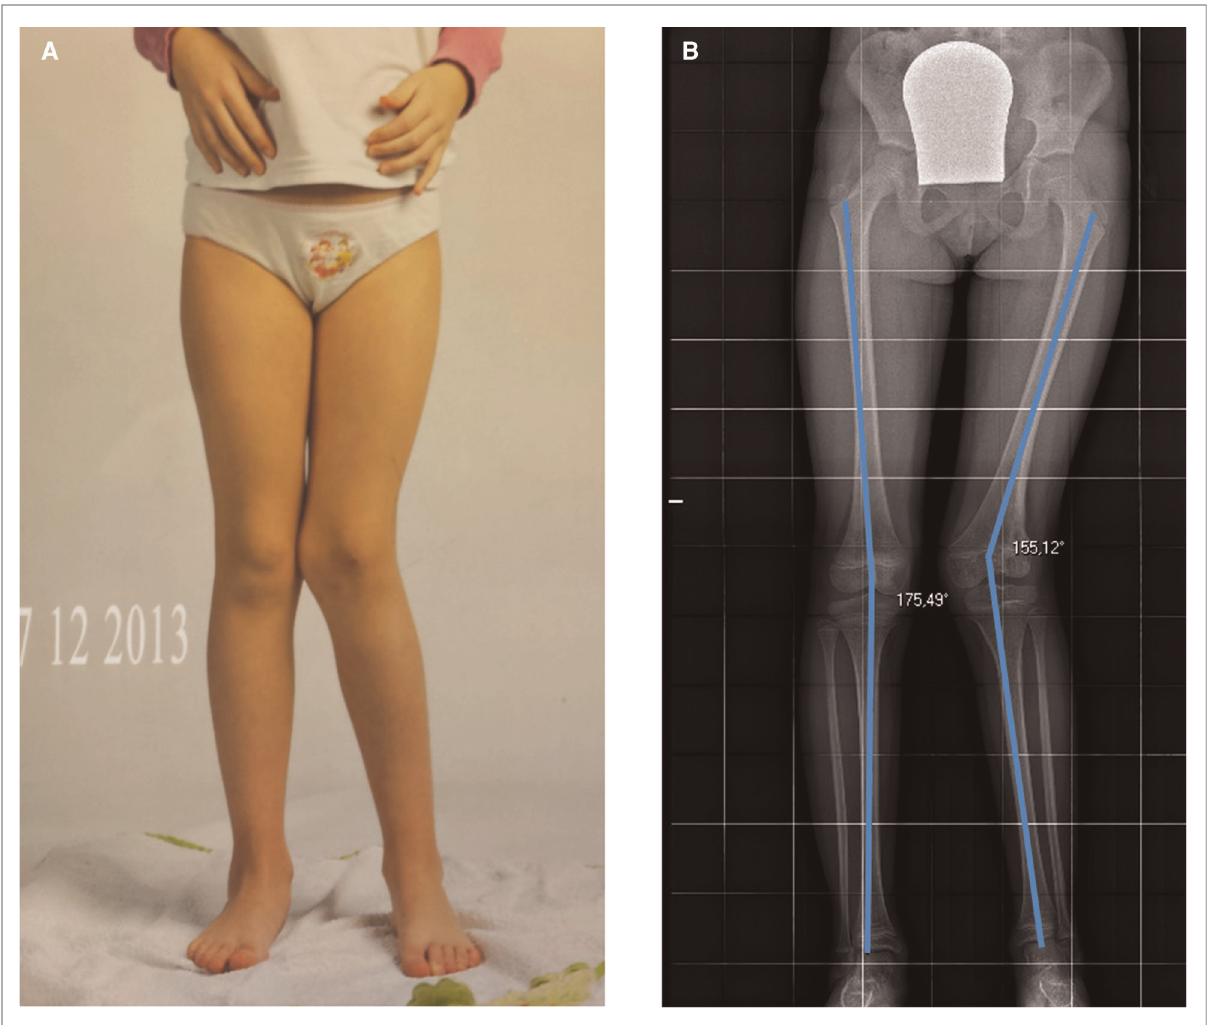
FIGURE 6 Twenty-month post-trauma follow-up showing 20° valgus deviation of the left knee with respect to the contralateral side. ( A ) showing clinical results, ( B ) showing radiological